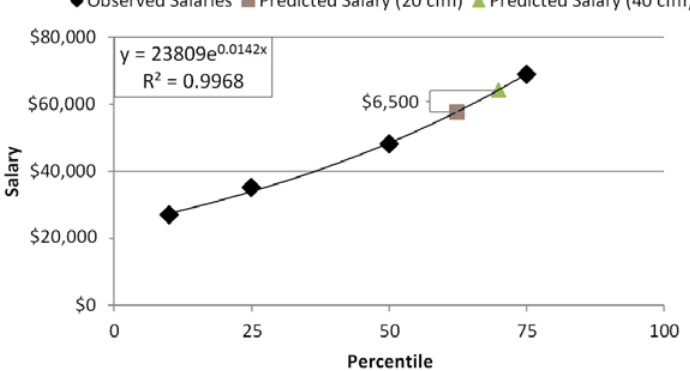
Figure 2. Observed salaries from the Bureau of Labor Statistics for common office occupations, regressed with an exponential function. This equation was used to interpolate salaries at the cognitive testing